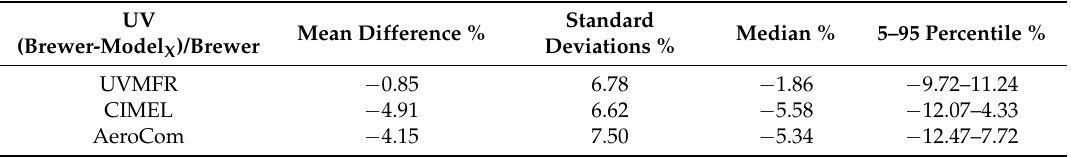
Table 2. Statistics of RTM calculated Irradiance at 324 nm compared to Brewer recordings at 324 nm for all available data.